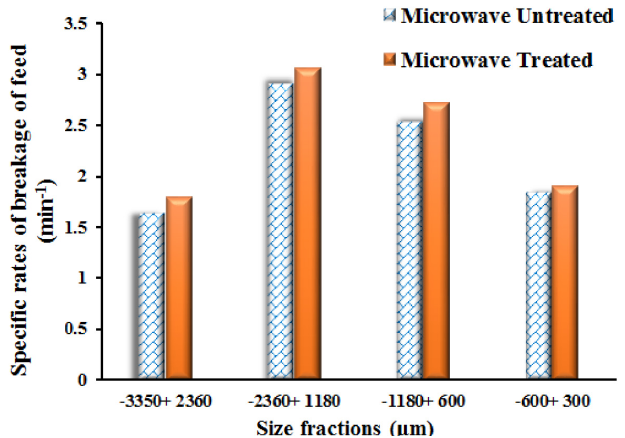
Fig. 8. Specific rates of breakage of feed against size